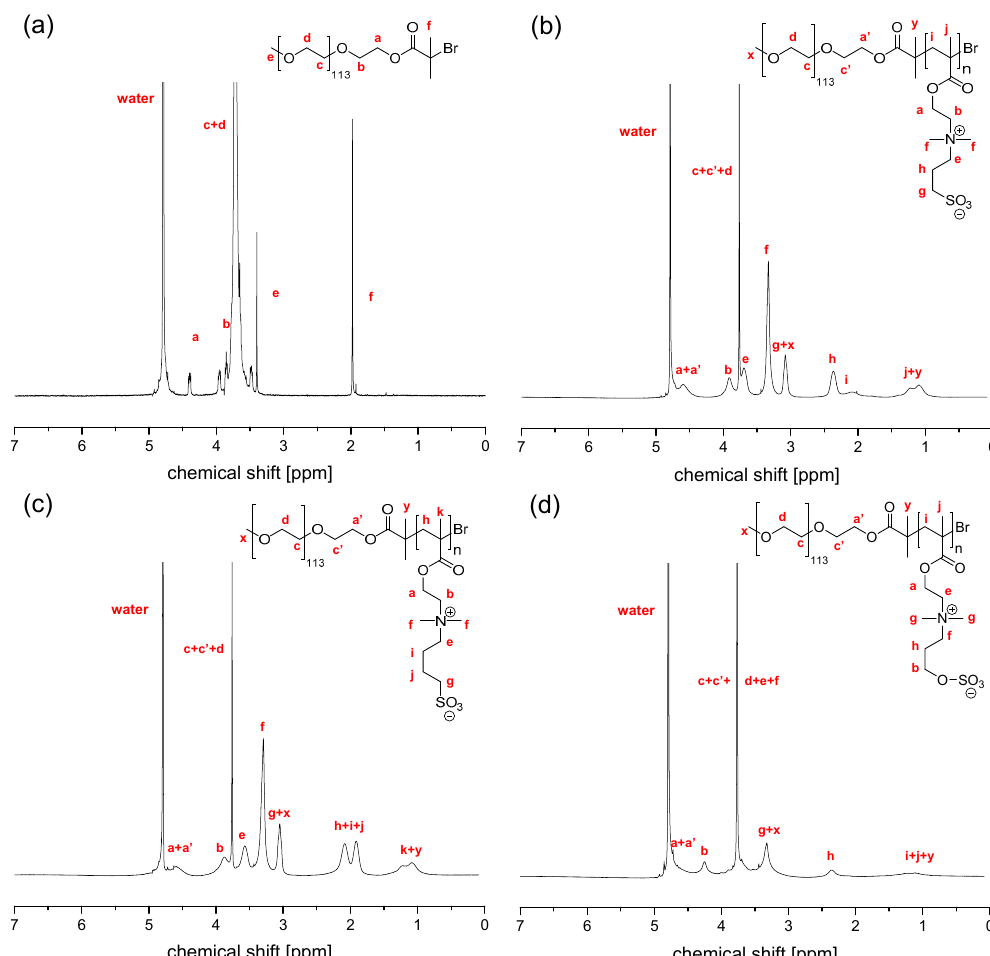
Figure 2. 1 H NMR spectra of ( a ) macroinitiator mPEG-Br in D 2 O, and of the derived block copolymers in 0.5 M aq NaCl: ( b ) mPEG- b -PSPE-6, ( c ) mPEG- b -PSBE-2, and ( d ) mPEG- b -PZPE-1.